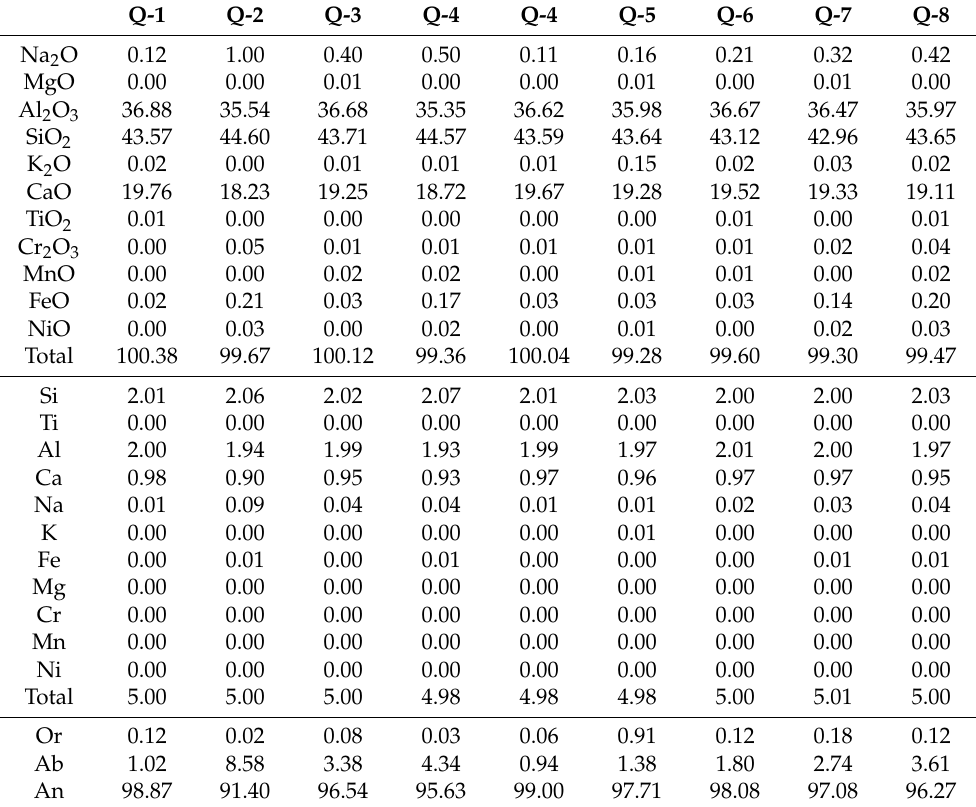
Table 2. Chemical compositions of the plagioclase